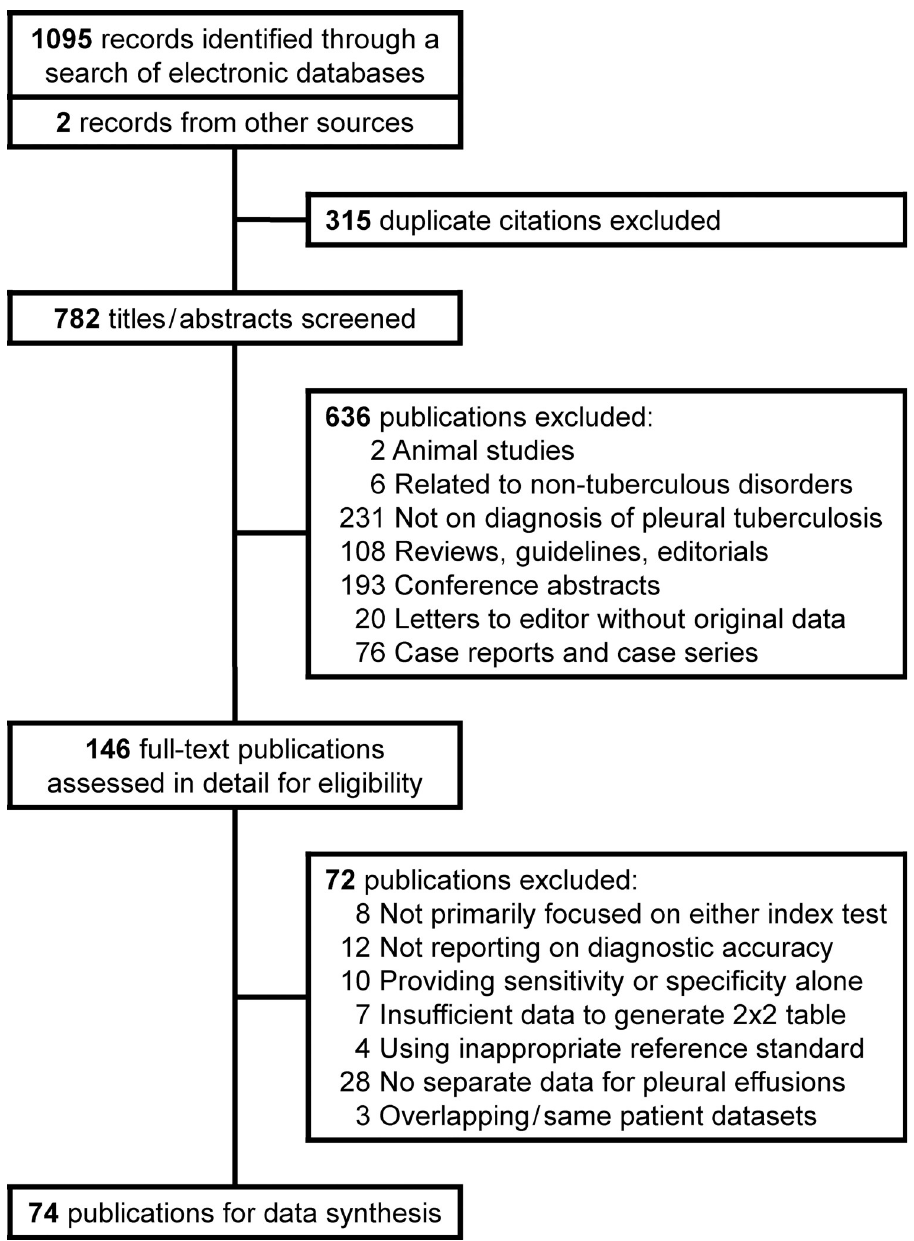
Fig 1. Study selection